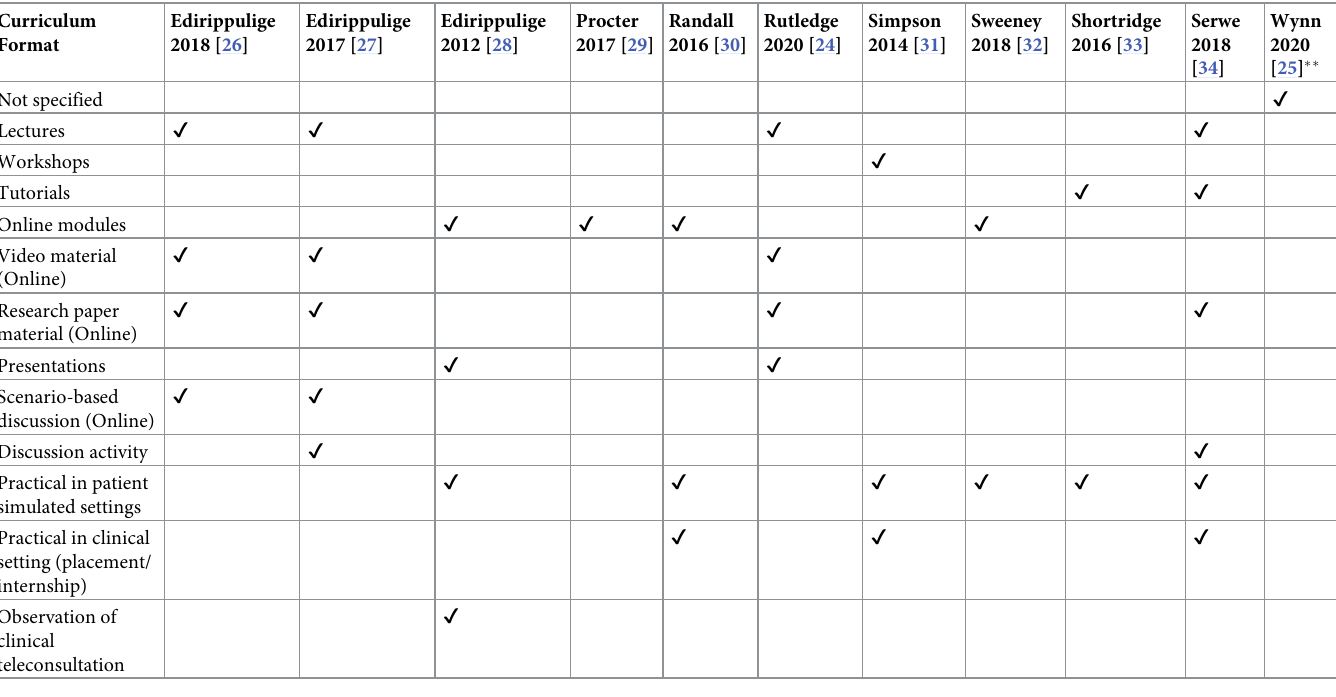
Table 5. Telehealth curricula format �